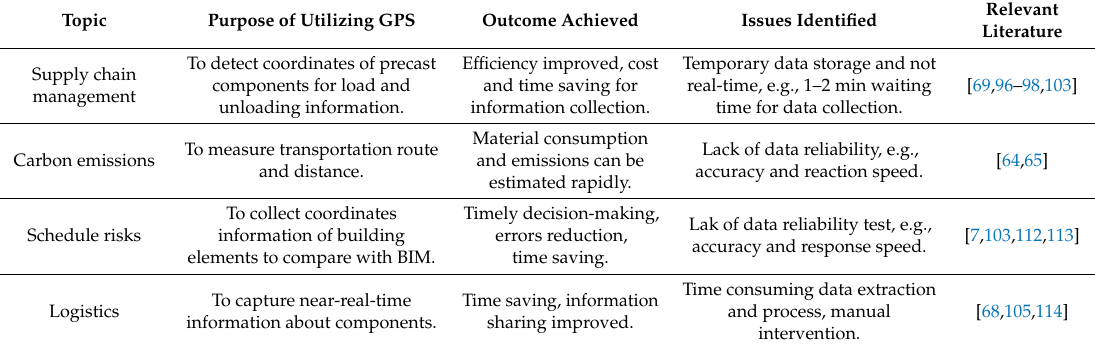
Table 6. Research topics, purpose of global positioning system (GPS) adoption, and outcomes achieved in previous